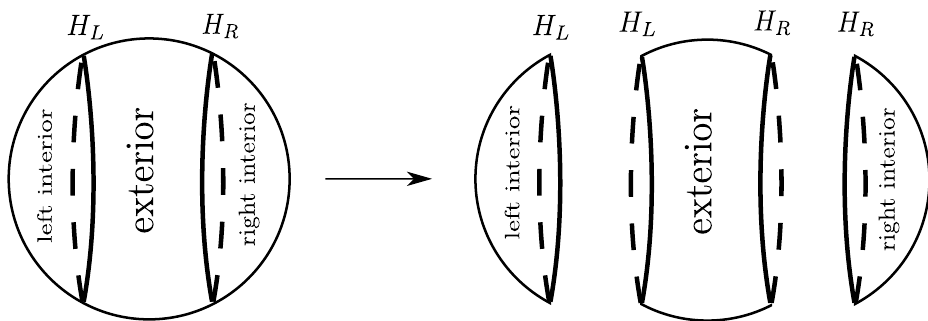
Figure 6 . A global time slice of de Sitter, with the horizons H L and H R . The entropy of a subregion h on H is computed by an extremal surface which contains ∂h and whose interior L ∪ H R includes h and no other piece of H . This is equivalent to breaking up the sphere into three L ∪ H R pieces as in the right image, and doing a single extremization where each surface is anchored to ∂h as in ordinary AdS/CFT. Thinking of the horizons as AdS boundaries makes the homology rule identical to that case. In the classical case with topology fixed as above we can perform three independent extremizations for each